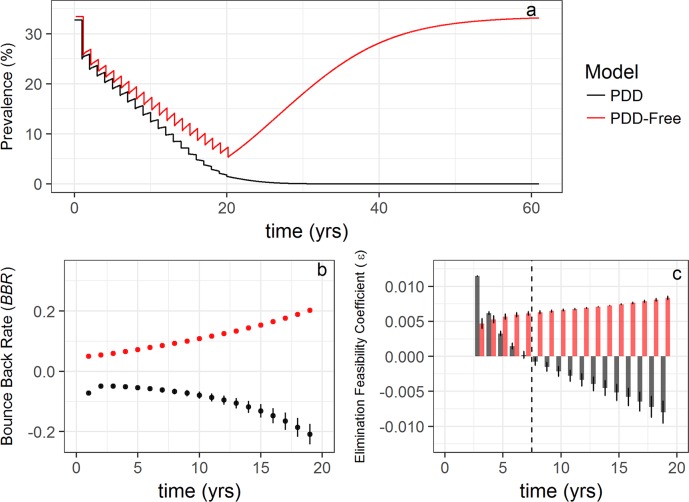
Influence of PDD on key model outputs estimated with prevalence.(a) Prevalence profiles derived from the PDD model (black line) and PDD-free model (red line) during 20 rounds of simulated annual MDA followed by 40 years with no intervention (the prevalence trajectory from the PDD-free model is shifted two months along the axis to improve clarity). In the presence of PDD, prevalence remains at 0% even after releasing MDA (a), while a lack of PDD allows the prevalence to rebound back to pre-MDA levels once MDA stops. (b) Mean prevalence-based BBR values of 100 model runs across 20 annual treatment rounds with error bars indicating standard deviation. (c) The prevalence-based elimination feasibility coefficient, ε, for the PDD model (black bars) and the PDD-free model (red bars) across each round of MDA. Error bars represent standard deviation and the dashed line between years 7 and 8 indicates the timepoint at which ε becomes significantly (p<<0) negative.